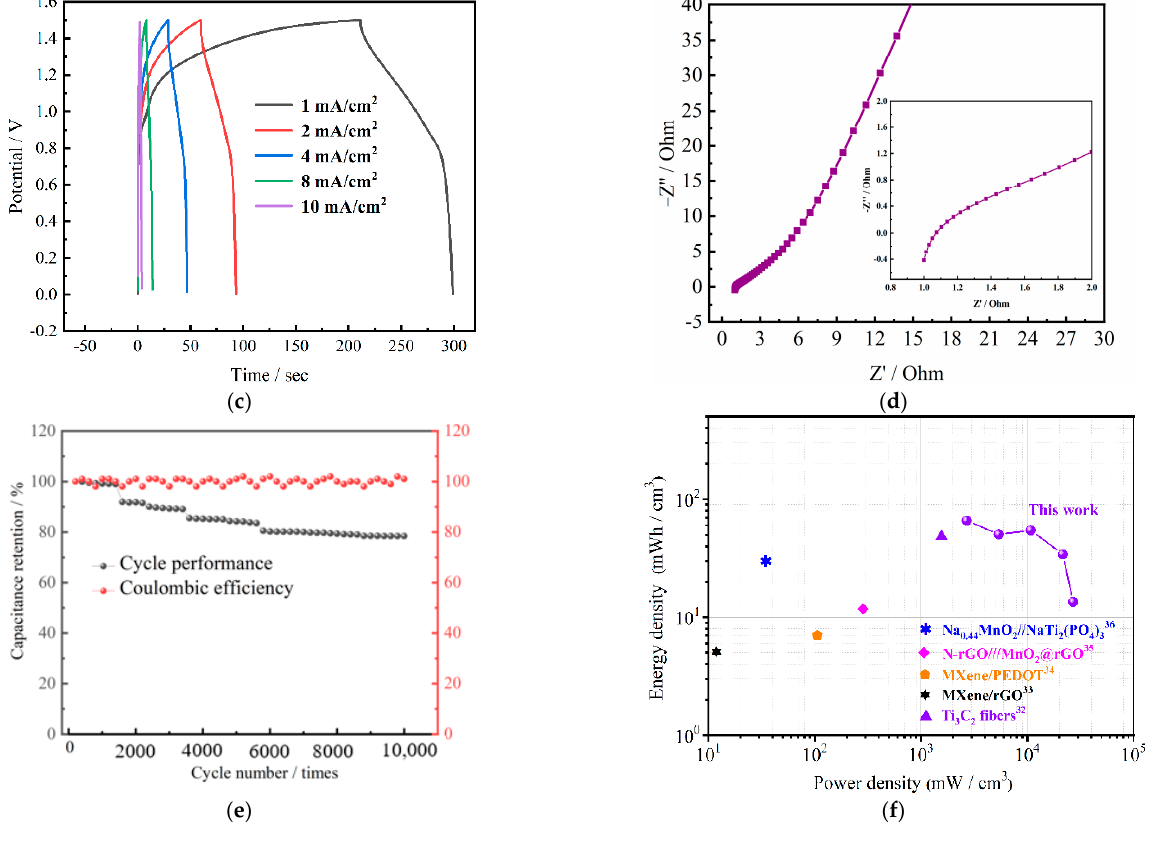
Figure 6. Electrochemical testing of NiMoO 4 @MnCo 2 O 4 composite assembled devices: ( a ) Cyclic voltammetry curves under different voltage windows; ( b ) Cyclic voltammetry curves of different scanning speeds; ( c ) GCD curves with different current densities; ( d ) Impedance diagram (inset is the high-frequency region); ( e ) Cycling stability and coulombic efficiency; ( f ) Ragone plots.